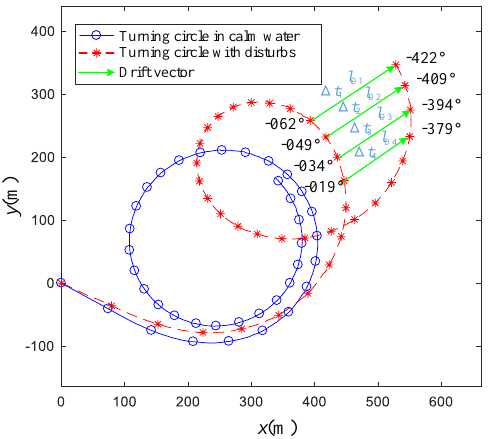
Figure 1. Traditional correction method of turning circle test.